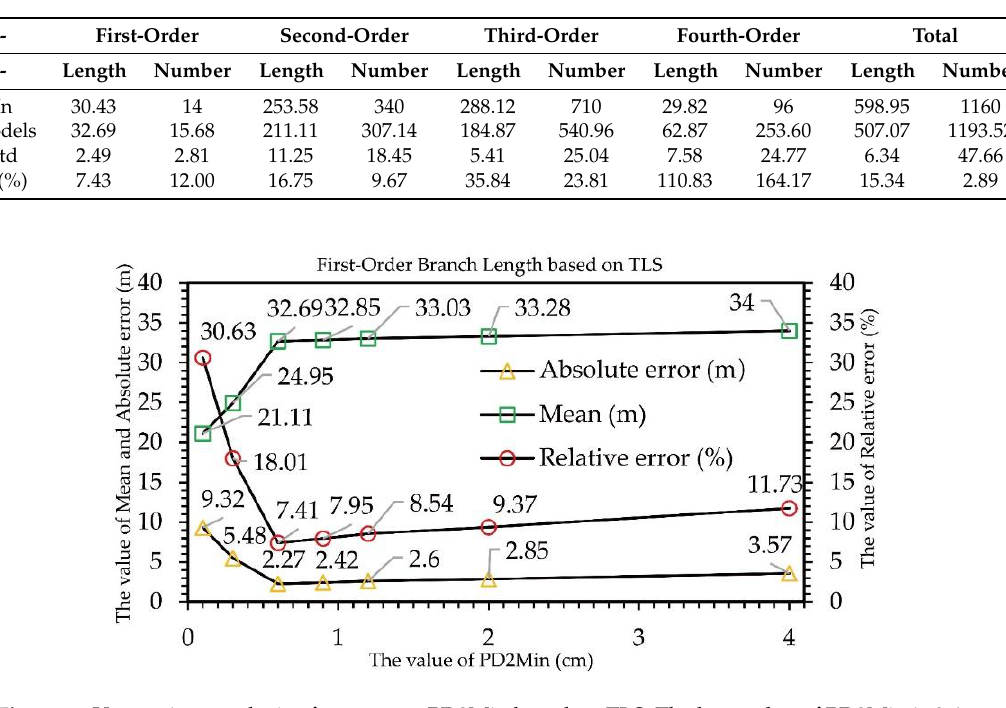
Table 2. In situ measured and quantitative structural models (QSMs) estimated branch information of tree 6 based on TLS. In represents in situ measured; Models represent estimated QSMs. The standard deviation of 50 attempts and relative error estimation of every order of branch information and total information. Std represents the standard deviation; R represents relative error. (unit of length: m).